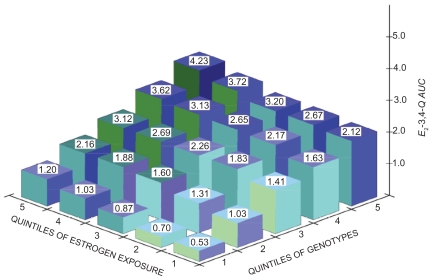
Three-dimensional graph displaying estrogen metabolomic-genomic model of breast cancer risk. The risk is represented by the amount of carcinogenic estrogen quinone, E2-3,4-Q AUC, which is produced by the metabolism of estrogen catalyzed by the enzymes CYP1A1, CYP1B1, and COMT. In theory, all enzyme genotype combinations could be plotted. However for clarity, we have plotted representative combinations from lowest to highest, separated into quintiles based on their respective E2-3,4-Q production: (1) CYP1A1461Thr-462ValCYP1B148Gly-119Ala-432Val-453SerCOMT108Val (2) CYP1A1461Thr-462ValCYP1B148Arg-119Ala-432Val-453AsnCOMT108Met, (3) CYP1A1461Thr-462Ile CYP1B1 48 Arg-119Ala-432Val-453SerCOMT108Val, (4) CYP1A1461Thr-462Ile CYP1B148Arg-119Ala-432Val-453SerCOMT108Met, (5) CYP1A1461Asn-462IleCYP1B148Arg-119Ser-432Val-453AsnCOMT108Met. Following the characterization of GSTP1 variants, we will include GSTP1 genotype data in the model. Cumulative estrogen exposure is displayed in quintiles. Actual E2 values, measured in pmol/L, could be plotted, in combination with semi-quantitative estimates of each woman’s overall exposure to estrogen. The latter is derived by taking into account her total years of ovulation as a function of current age, age at menarche, age at menopause, numbers of full-term pregnancies and lactation experience for each, and the dosage and duration of the use of exogenous estrogens. (The authors acknowledge work of Eric Parl in the design and preparation of this figure).